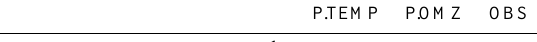
Table 1. Standard deviation and correlation coefficients between P.TEMP and P.OMZ parameterizations with respect to MEMENTO database observations (Bange et al., 2009). P.TEMP